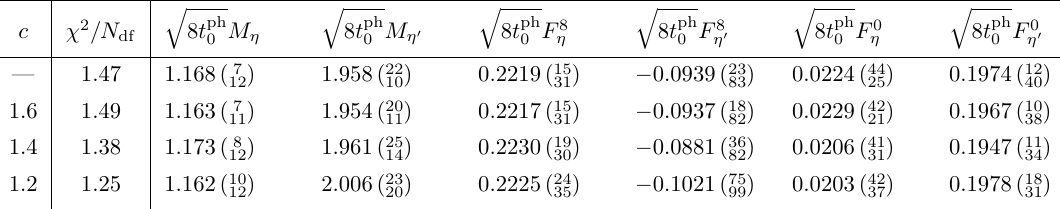
Table 13. Results for masses and decay constants of the η and η 0 at the physical point in units of the gradient flow scale obtained when employing fit 7 of table 7 and imposing cut-offs 12 t 0 M 2 < c , as well as including all the data (first row).